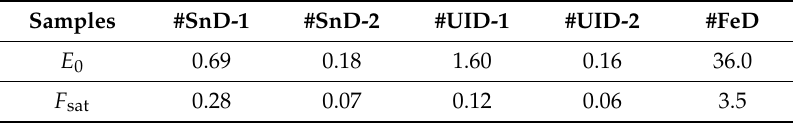
Table 2. Estimated parameters at an excitation wavelength of 245 nm.